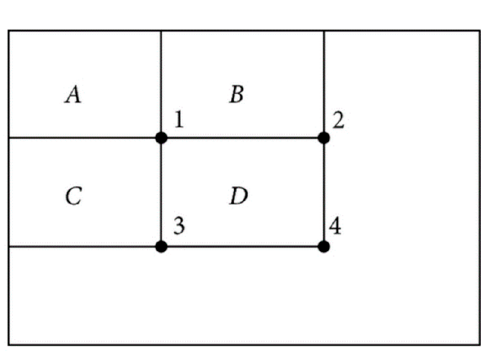
Figure 1. Integral image blocks.